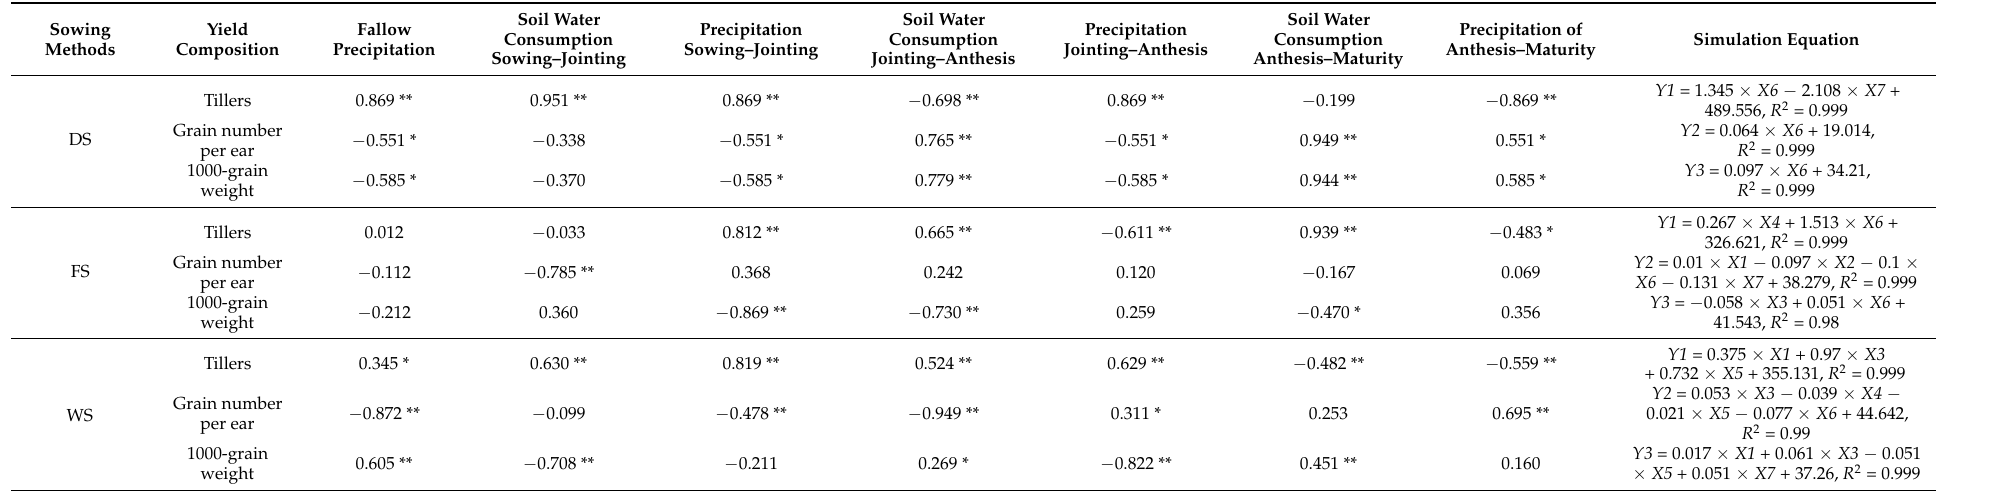
Table 4. Correlation between yield components and water source